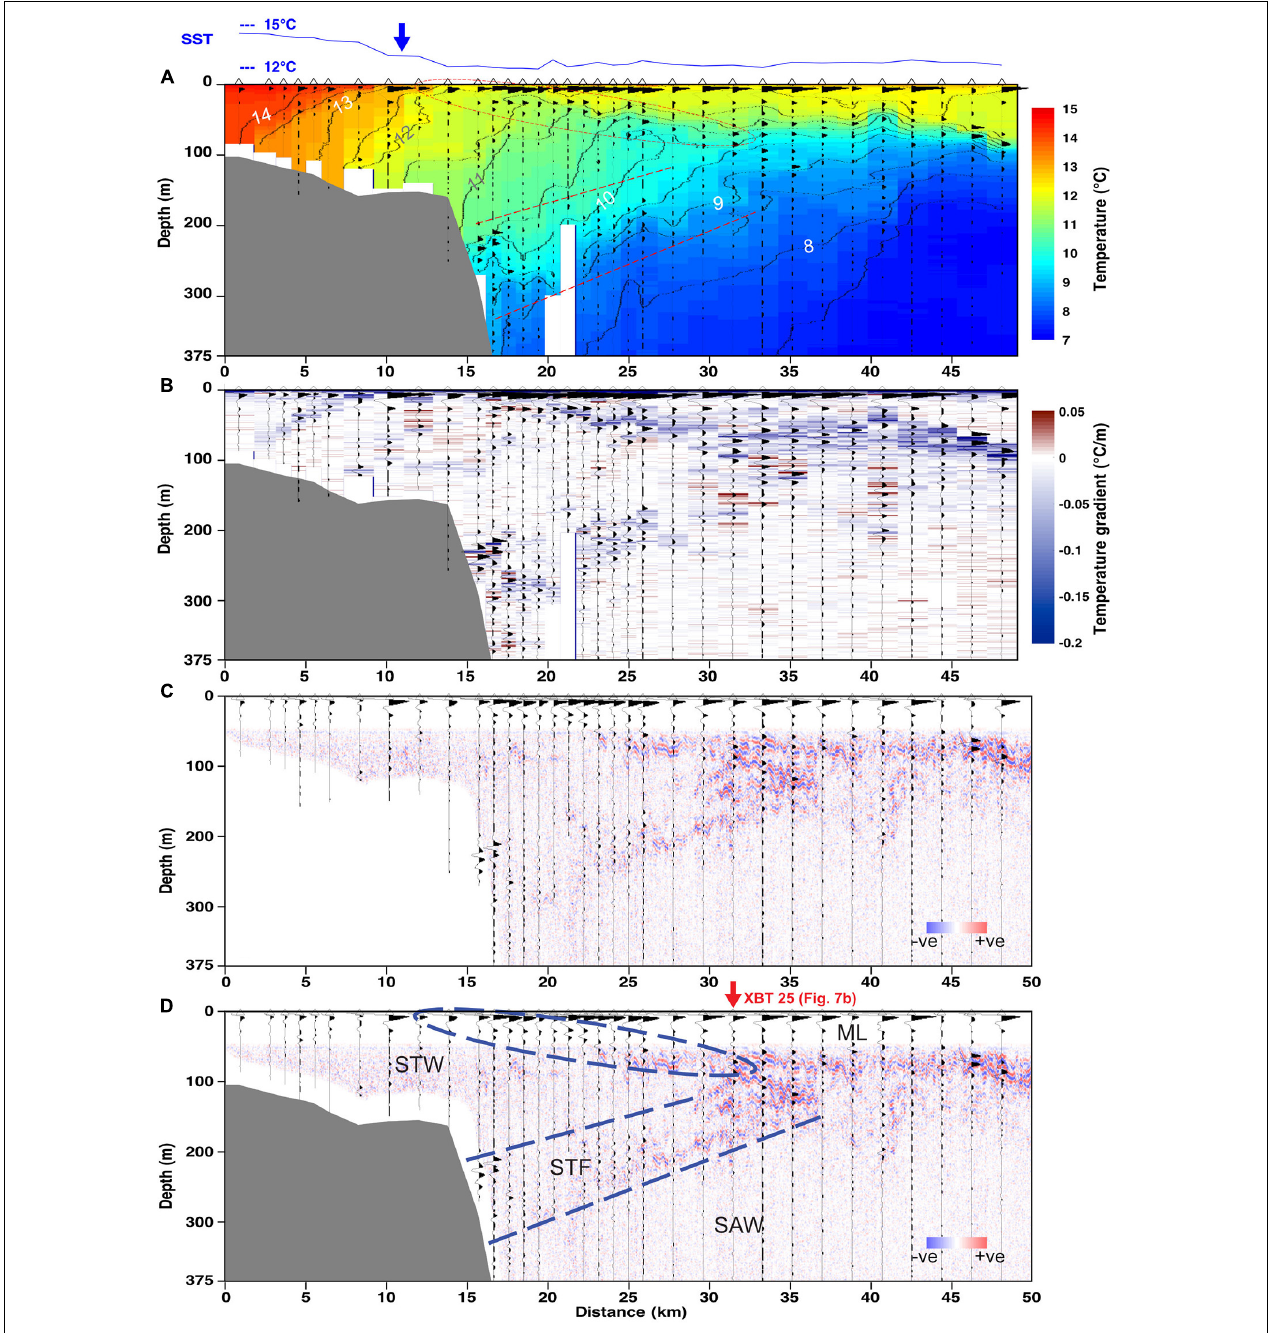
FIGURE 5 | (A) Temperature, (B) vertical temperature gradient, (C) uninterpreted seismic image, and (D) interpreted seismic image for line KAH1201-1, with synthetic seismograms overlain on each image. Shoreward- and seaward-dipping reflective zones separating interpreted water masses are highlighted by dashed lines. STW, Subtropical Water; STF, Subtropical Front; SAW, Subantarctic Water; ML, mixed layer. The surface temperature trace, with approximate surface STF location indicated with an arrow, is shown at the top of (A) . Arrow in (D) indicates the location of XBT shown in Figure 7 .